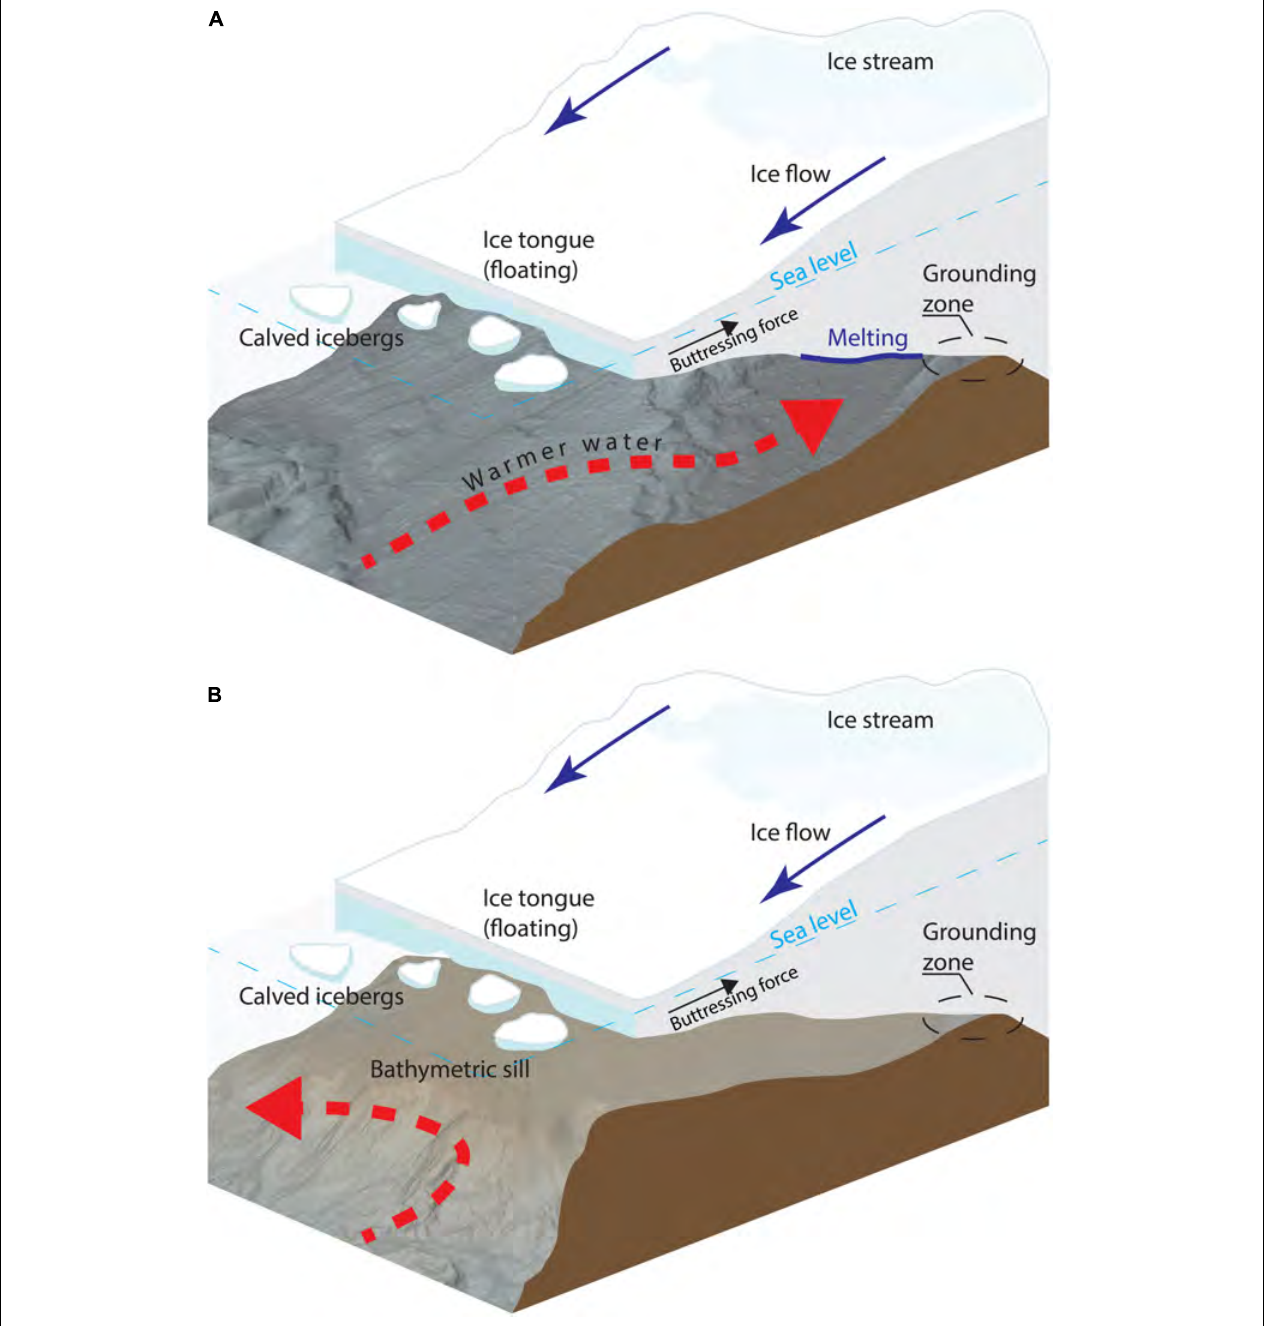
FIGURE 2 | Schematic illustrations of how bathymetry may influence the inflow of subsurface warmer water in a fjord hosting a marine outlet glacier. (A) A seafloor without any bathymetric feature preventing warmer water from entering and reaching the underside of the glacier to exert melting. (B) A bathymetric sill shielding the glacier by preventing the warmer sub-surface water from flowing in underneath the glacier. In addition, scenarios exist with smaller sills only partly shielding the glacier as further discussed in the main